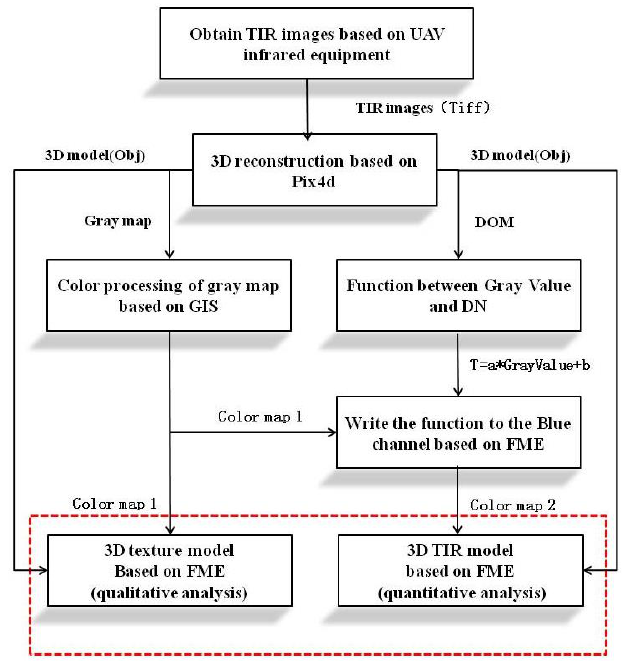
Figure 1. Reconstruction process of the 3D model.